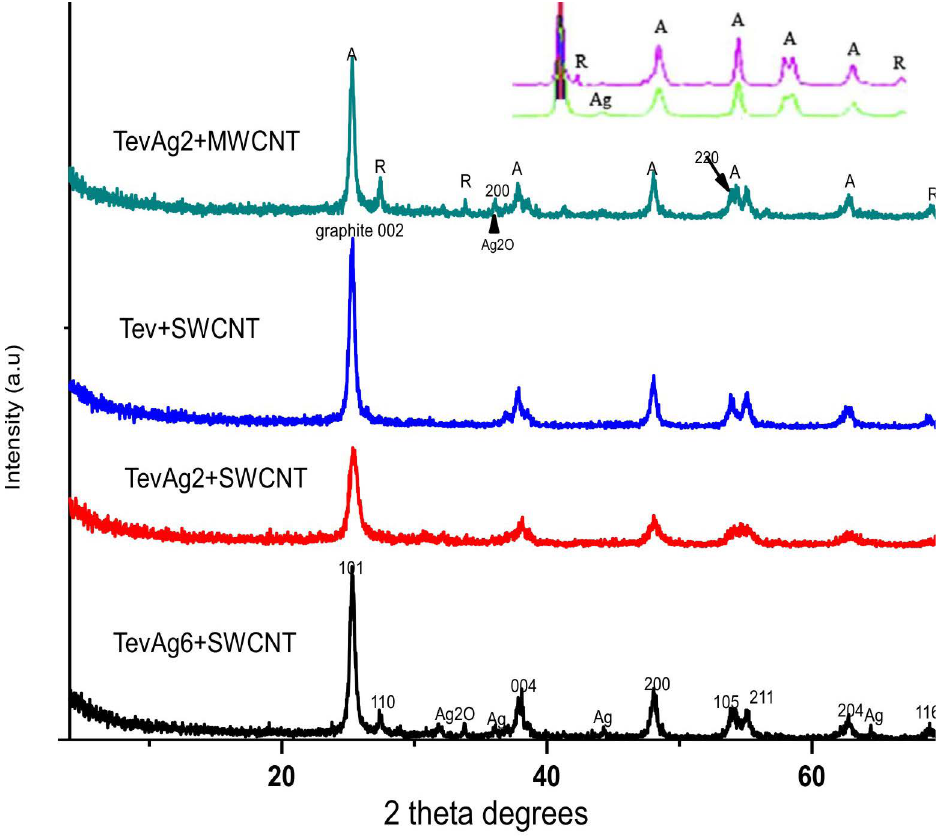
Fig.1 . XRD patterns of TNT-SWCNT, TevAg2-SWCNT, TevAg2-MWCNT and